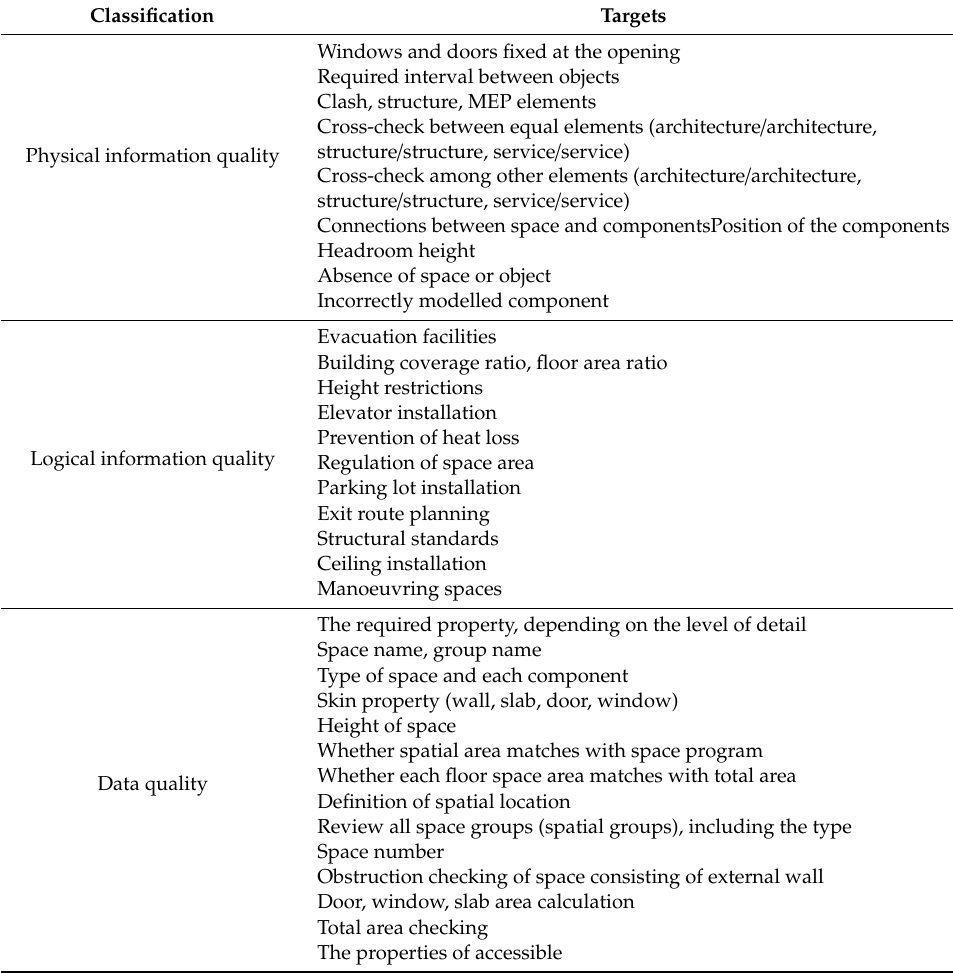
Table 5. Quality check target arrangements by